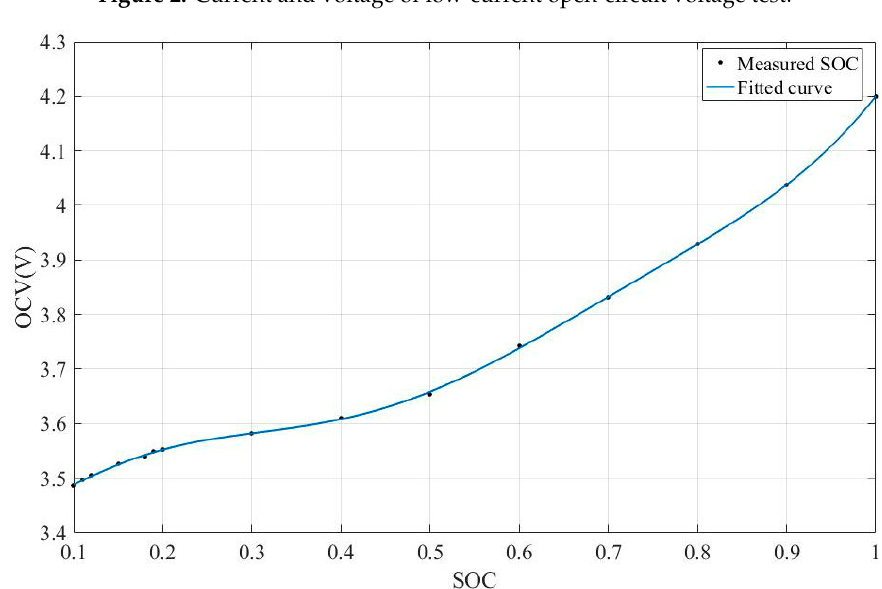
Figure 3. Curves at low-current